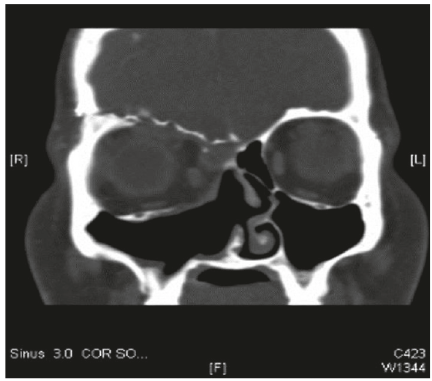
Figure 11: Postoperative paranasal coronal CT